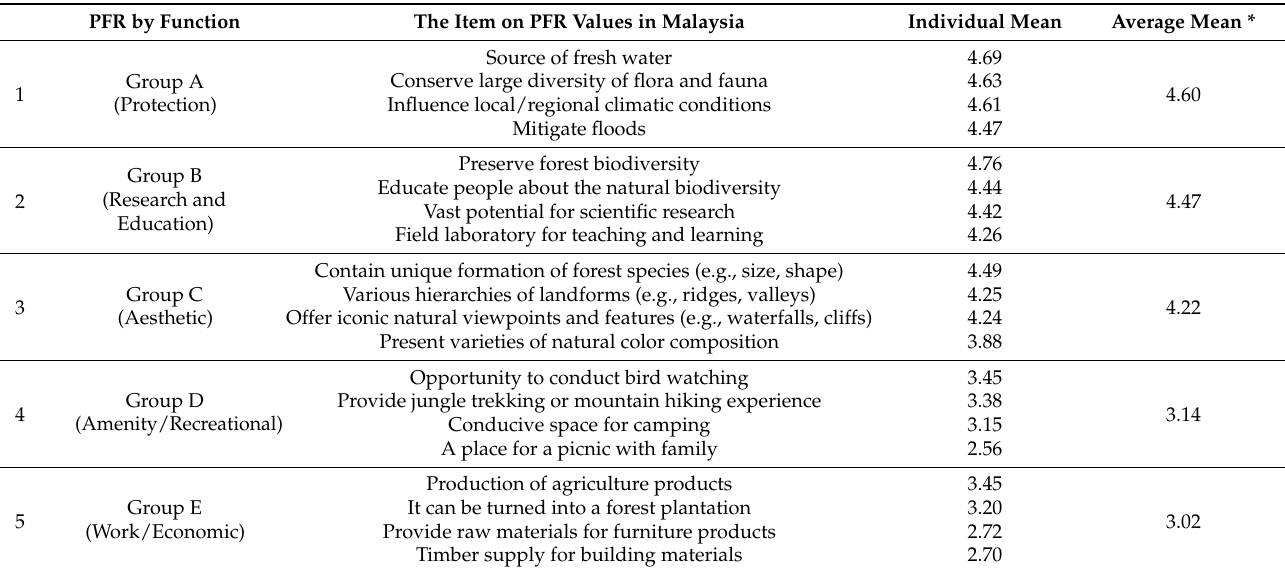
Table 7. The preservation group of permanent forest reserves by